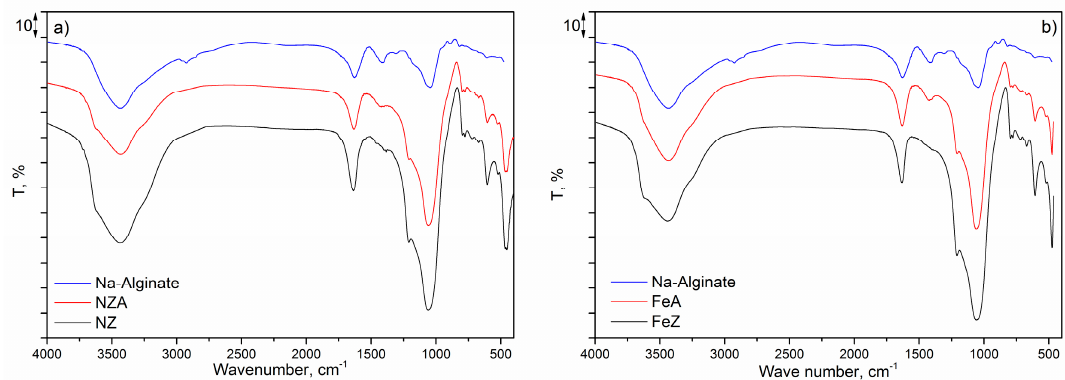
Figure 3. Fourier transform infrared (FTIR) spectra of the Na-alginate and: ( a ) NZ and NZA; and ( b ) FeZ and FeA.